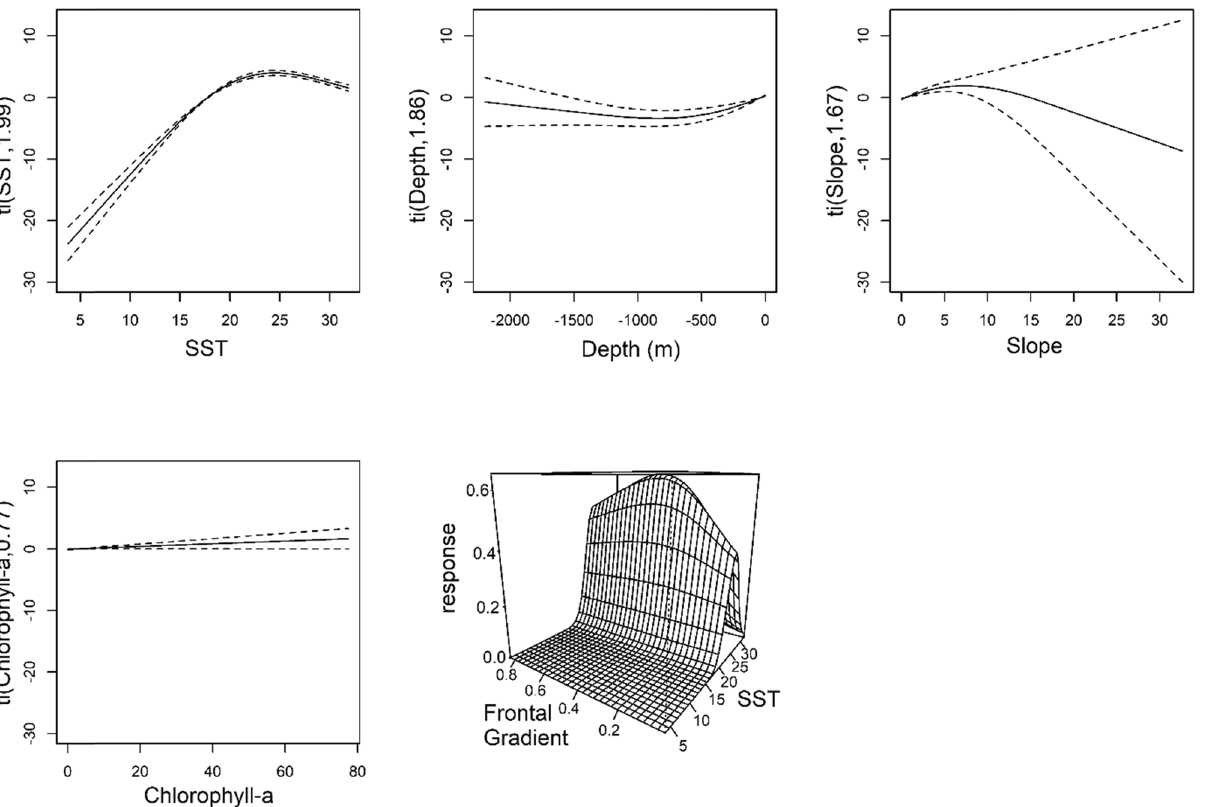
Figure 5. Significant species distribution model GAM predictor terms for combined surveys (SEFSC, NARWC, and NYSERDA) model, including sea surface temperature (SST; °C), Z-transformed SST frontal gradients, depth (m), Chlorophyll-a concentrations (mg/m 3 ), and bathymetric slope